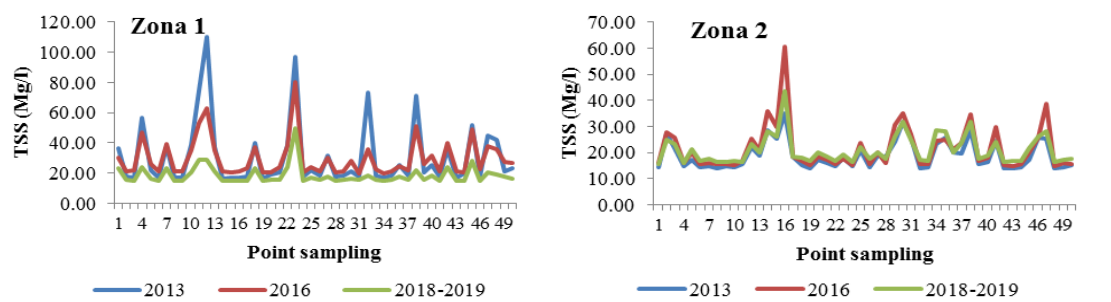
Figure 5. TSS (Mg / l) at each sampling point in Bontosua island as zona 1 and Ballang Caddi as zona 2 Spermonde waters in the west to east season on September-November 2013, 2016, dan 2018-2019